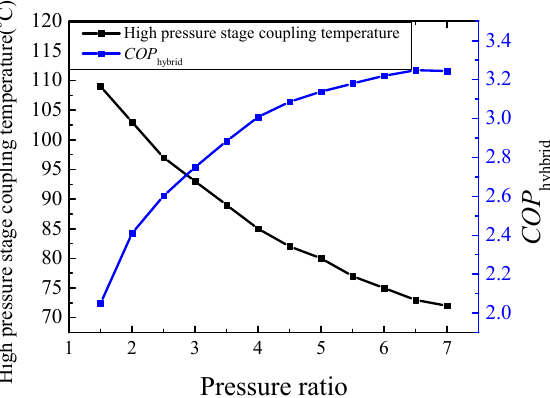
Figure 14. Optimal operating conditions and coupling cycle COP under different pressure ratios.